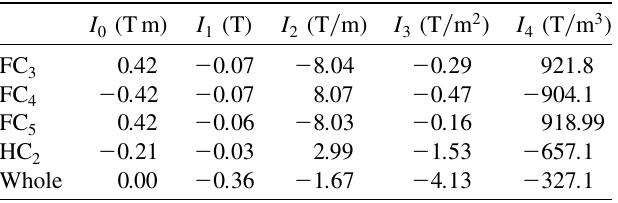
TABLE IX. Definitive configuration (entire wiggler): inte- grated coefficients of the field expansion for the poles at positive T is calculated from z (cid:3) (cid:6) 16 cm to z , except for FC where b 3 3 z (cid:3) (cid:7) 16 cm . I calculated in the entire wiggler is not exactly 3 at positive z , the double of the sum of the contributions of I 3 because of a small asymmetry of the beam trajectory in the two halves of the wiggler (the magnetic fields are equal for the symmetry of the model).